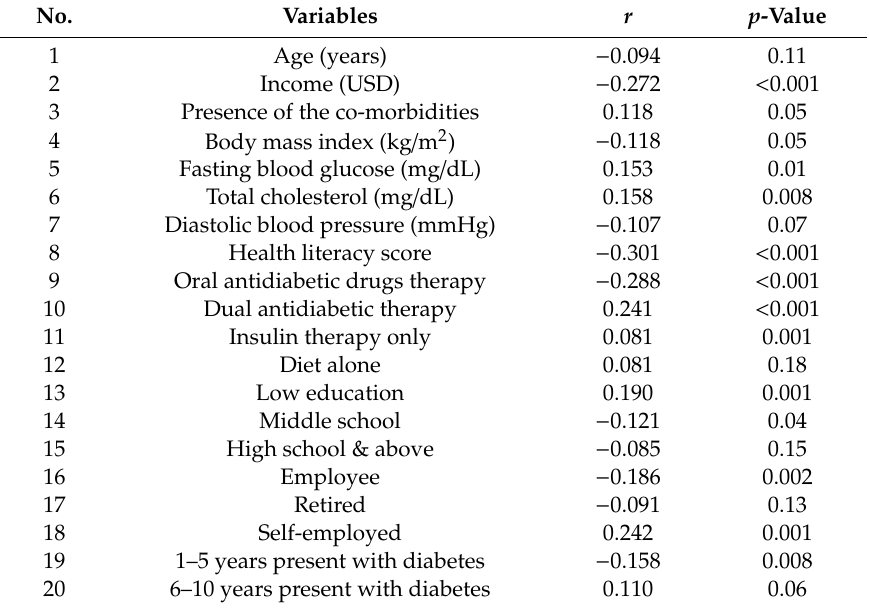
Table 3. Factors associated with glycemic control (HbA1c) of the respondents.